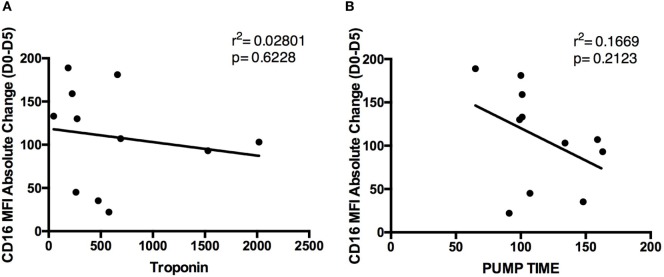
Relationship of peak troponin and pump time with CD16 mean fluorescence index (MFI) absolute change. Graphs representing correlations between absolute CD16 MFI change between day 0 and day 5 and (A) peak troponin levels and (B) pump time. Both parameters were not significant with CD16 MFI (n = 11).